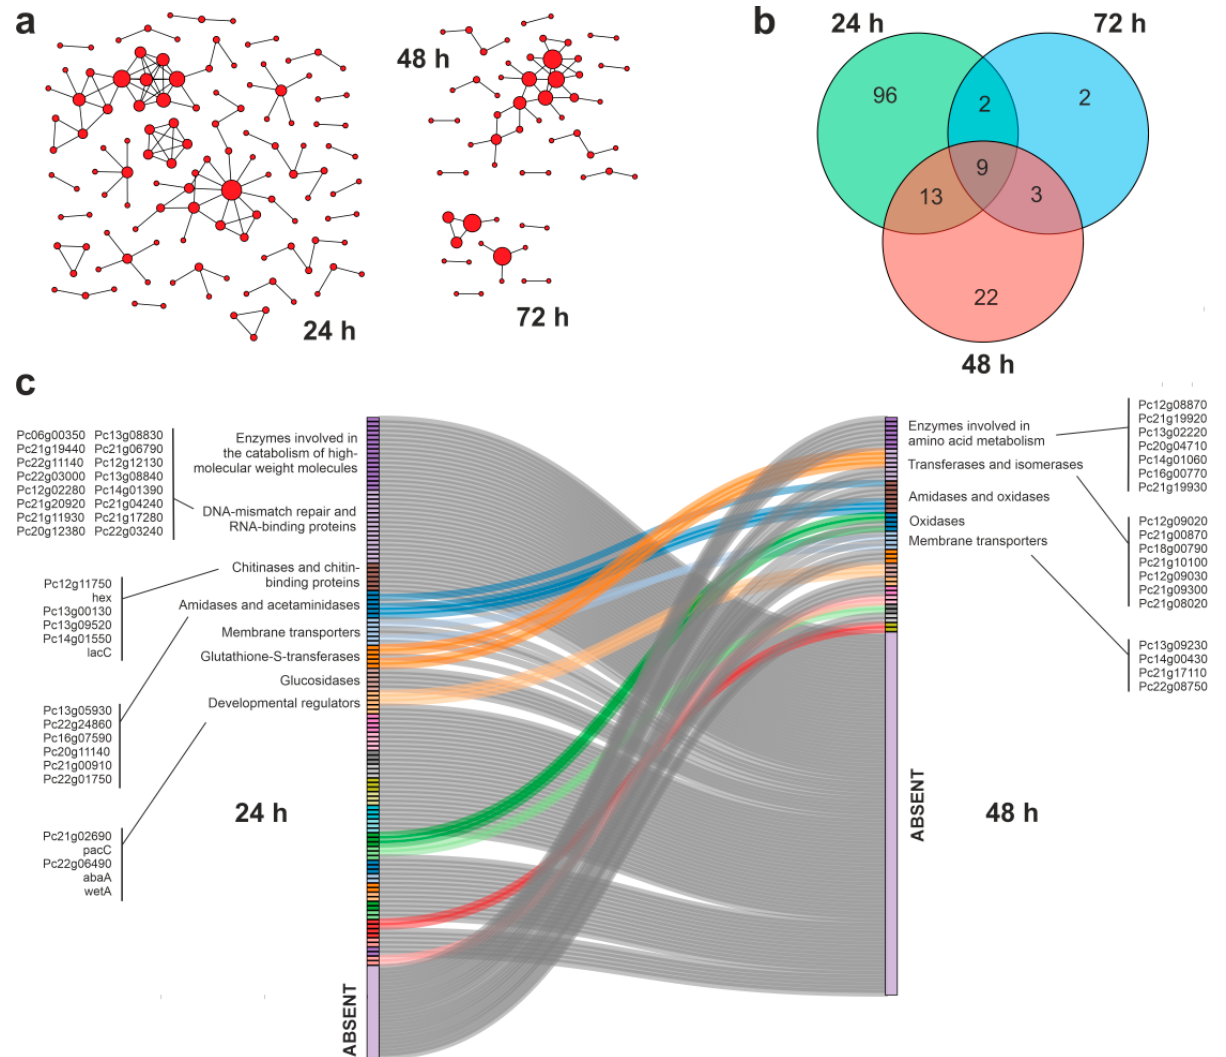
Figure 5. Analysis of the protein–protein interaction networks (PPIs) established among the proteins whose coding genes were overexpressed during APAP biodegradation by P. chrysogenum var. halophenolicum . The existence of the depicted PPIs was supported by the information deposited in the STRING database [46]. ( a ) schematic representation of the density of interaction nodes among the selected proteins at 24 h, 48 h, and 72 h of culture. ( b ) Venn diagram representing the number of proteins included in all the PPIs at the analyzed culture times. ( c ) Sankey plot showing the changes in community structure (densely connected groups of nodes) analyzed in the transition between 24 h and 48 h of culture performed by the Netconfer algorithm [47], illustrating the most relevant families of enzymes involved.